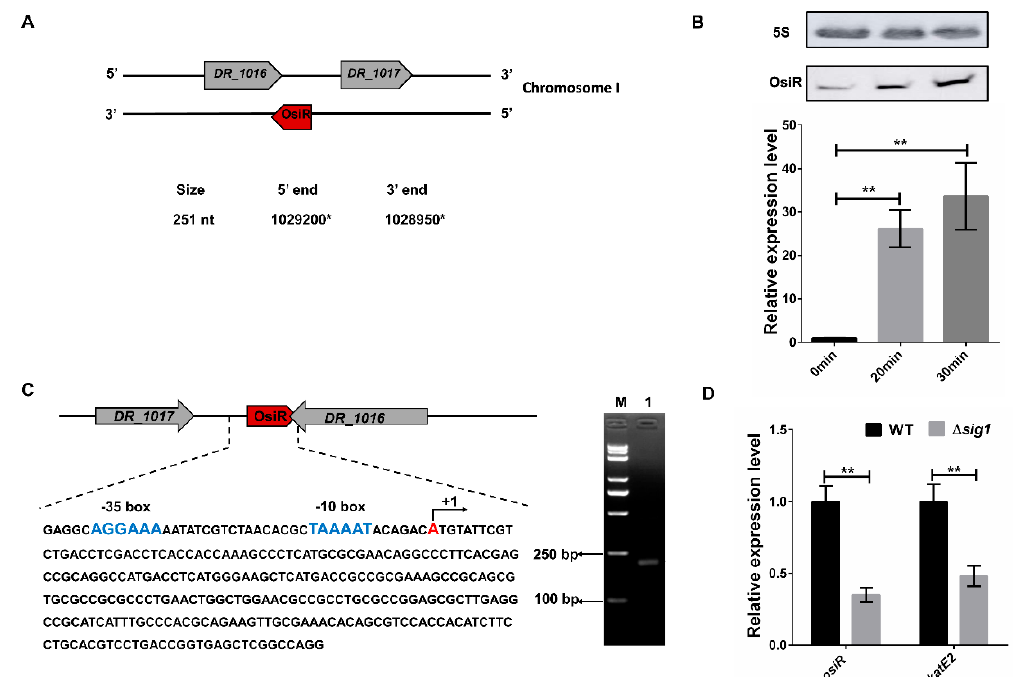
Figure 1. Expression and genomic context of OsiR. ( A ) the genomic location of osiR on chromosome I [37]; ( B ) transcript levels of osiR detected by Northern blot and qRT-PCR in D. radiodurans . 0 min, 20 min, 30 min indicates the time of H 2 O 2 treatment; ( C ) physical map and nucleotide sequence of osiR in D. radiodurans . (blue) − 10 box and − 35 box in the promoter of OsiR predicted by BPROM; (+1) transcription start site mapped by 5’RACE; M: Trans2K PlusII Marker; Lane 1: product of the second nested PCR for 5’RACE; ( D ) effect of a sig1 mutation on the expression of osiR and katE2 . The qRT-PCR data shown are the averages of three biological replicates. Error bars represent standard deviations. The statistical significance of the difference was confirmed by Student’s t -tests (**, p < 0.01).